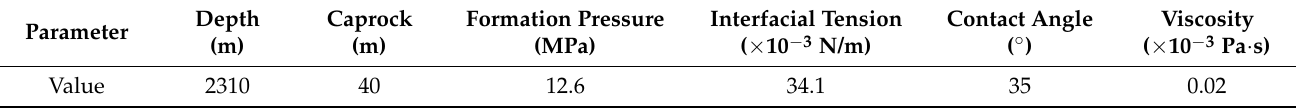
Table 3. Basic information of an underground gas storage.